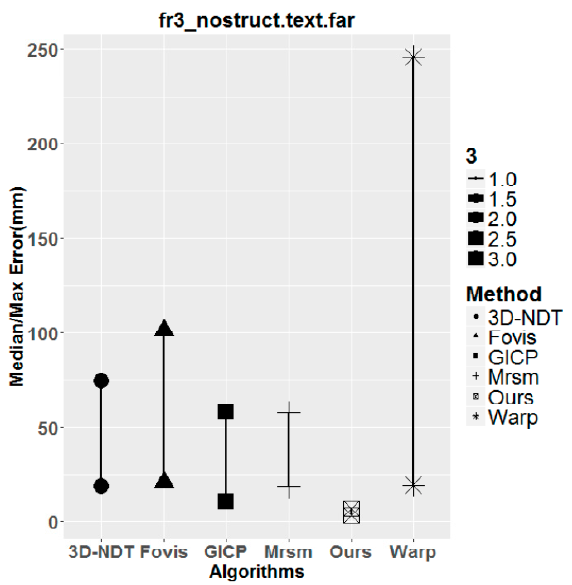
Figure 6. Comparisons of the median/max absolute trajectory error (ATE) in mm for incremental registration on RGB-D sequences from the Freiburg benchmark dataset. In each plot, different vertexes represent different methods. The higher vertexes represent the max ATE and the lower vertexes are the median ATE. Table 2. Running time of the TUM RGB-D sequences.